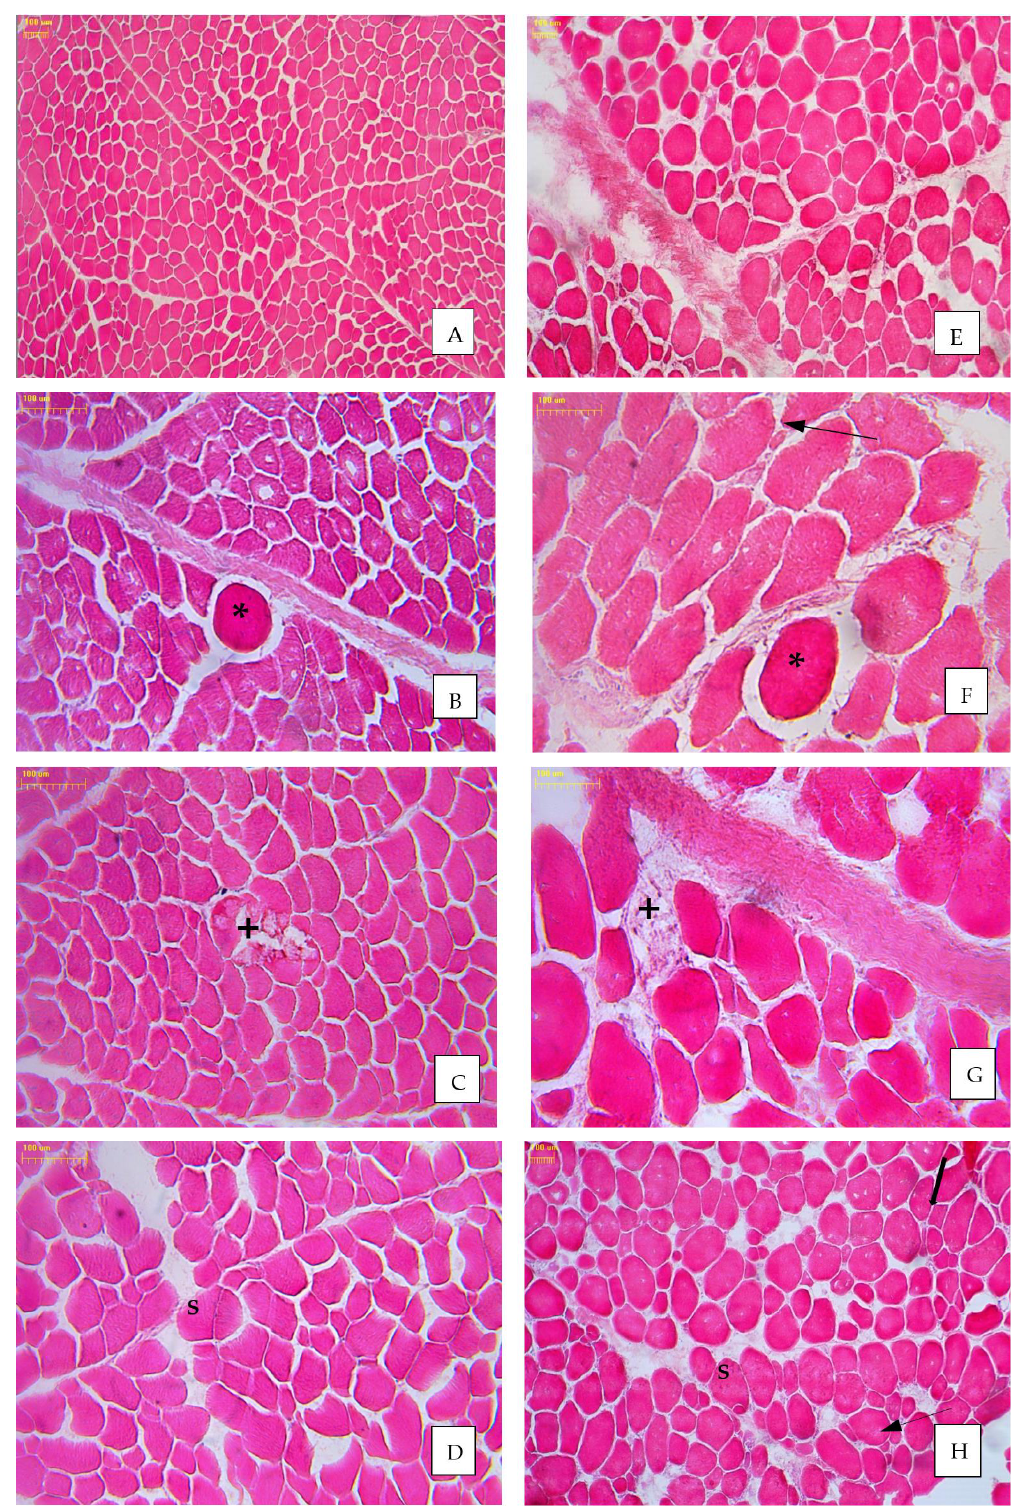
Figure 1. Microstructure of pectoral muscle of green-legged partridge (GP) chickens ( A – D ) and Ross 308 broilers chicken ( E – H ); HE stain; * giant fibres; + —necrotic fibres; S—fibre splitting; change shape of fibre (thick arrow); atrophic fibres (thin arrows); magnification × 100 ( A , E , H ); magnification × 200 ( B – D , F , G